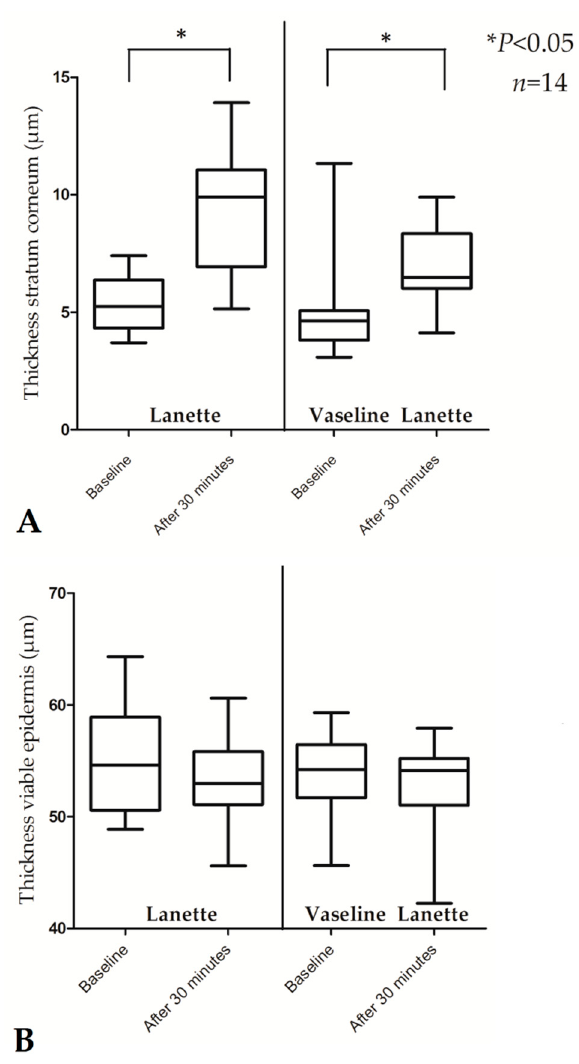
Figure 3. Thickness of stratum corneum ( A ) and viable epidermis ( B ) measured by the reflectance confocal microscope at baseline and 30 min after cream application. Values are expressed as medians with interquartile ranges and ranges (minimum–maximum).